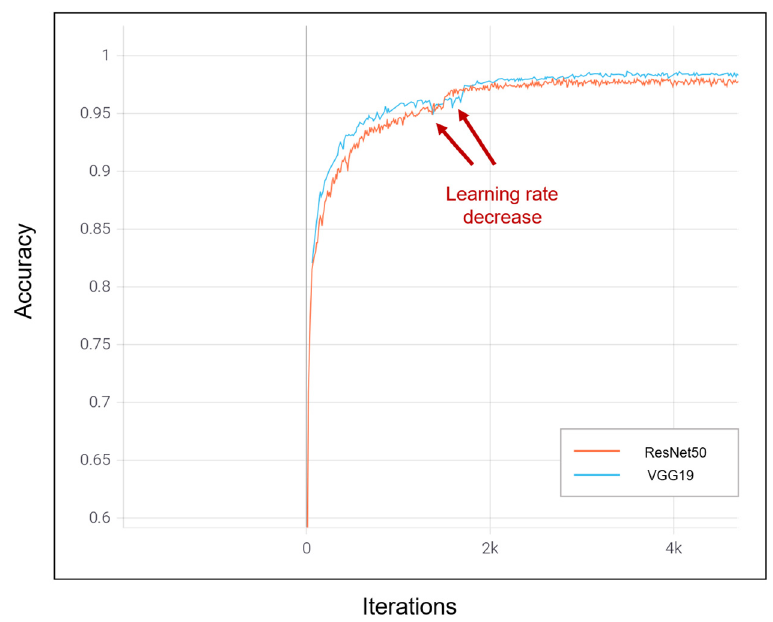
Figure 6. Training accuracy plots of VGG19 and ResNet50 models. Sudden jumps highlighted with red arrows refer to the learning rate decrease.